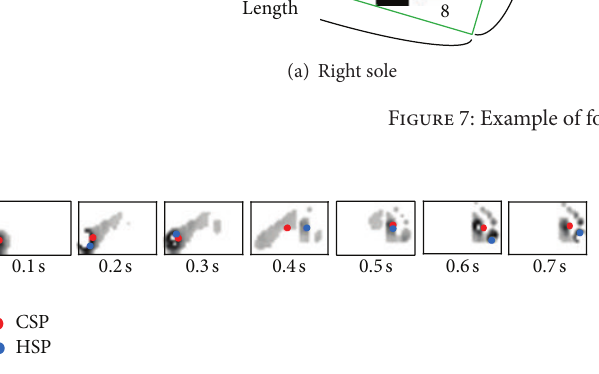
Figure 8: Example of CSP and HSP of each frame.